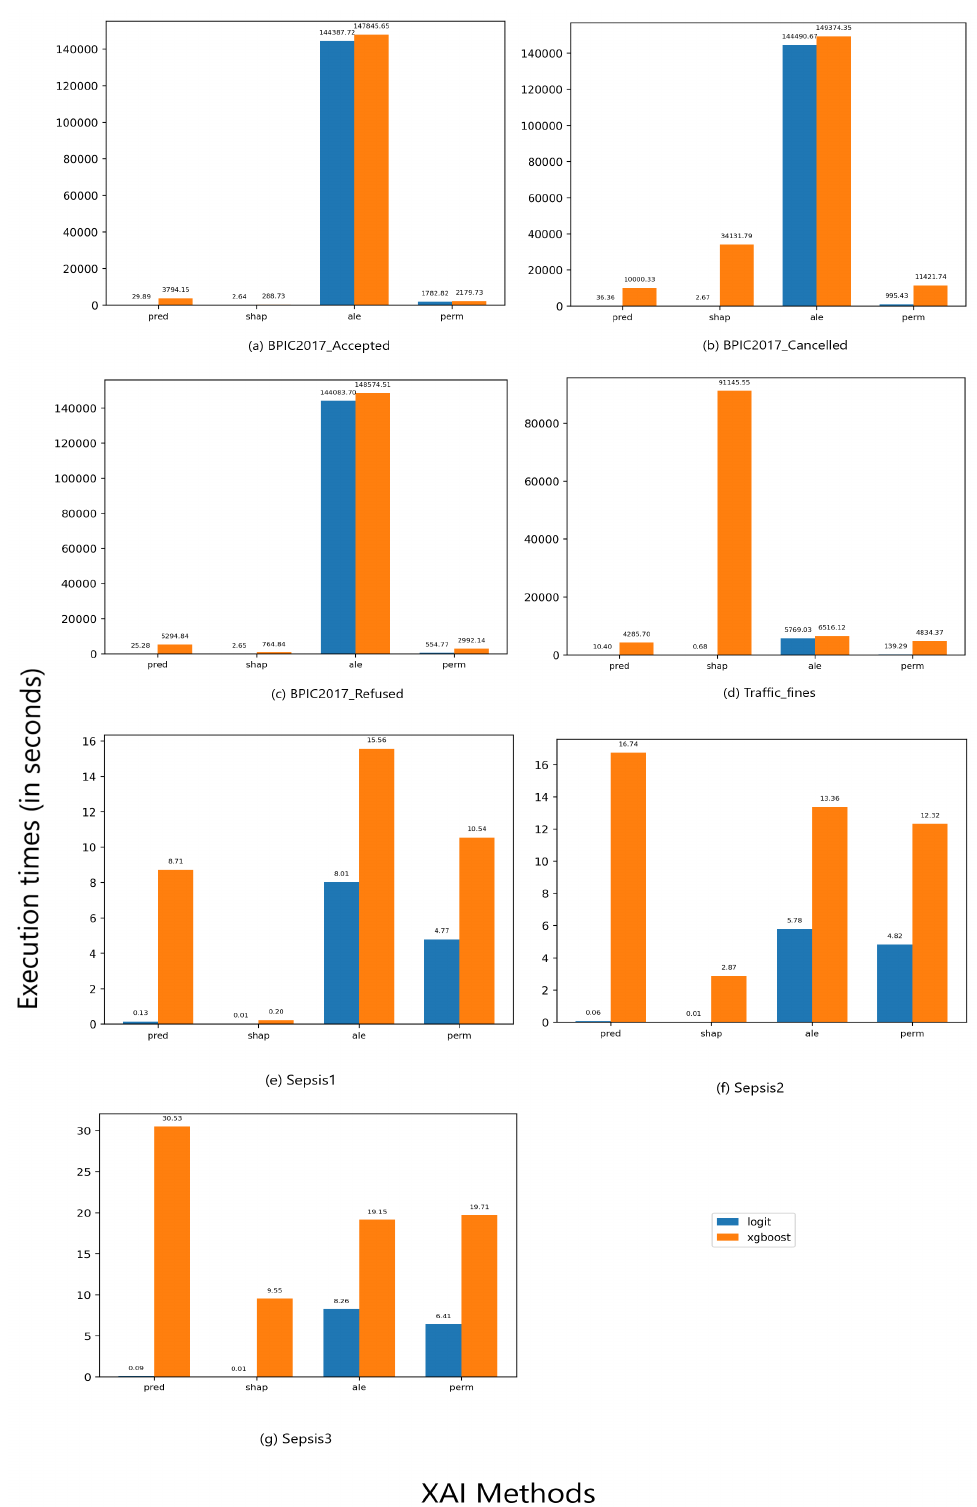
Figure A2. Execution times (in seconds) of XAI methods on event logs preprocessed using single aggregation